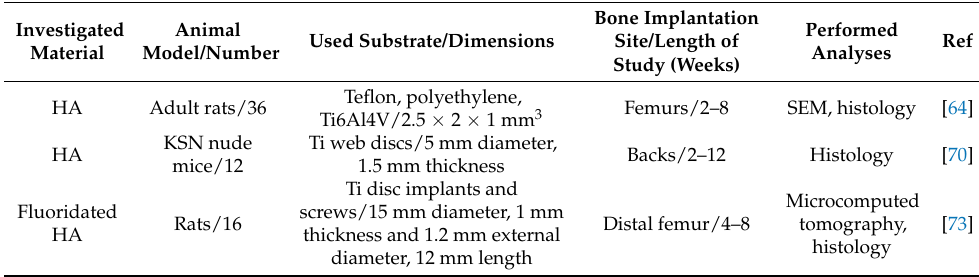
Table 3. Information related to the investigated coating materials, according to the applied small animal models (i.e., rats/mice).